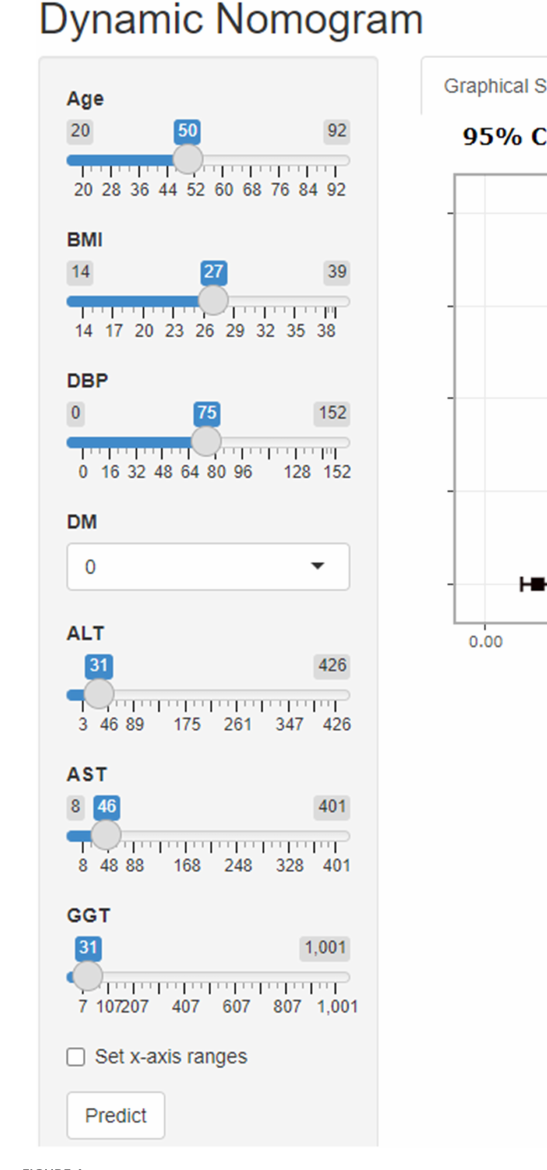
FIGURE4 The web version of the dynamic nomogram.